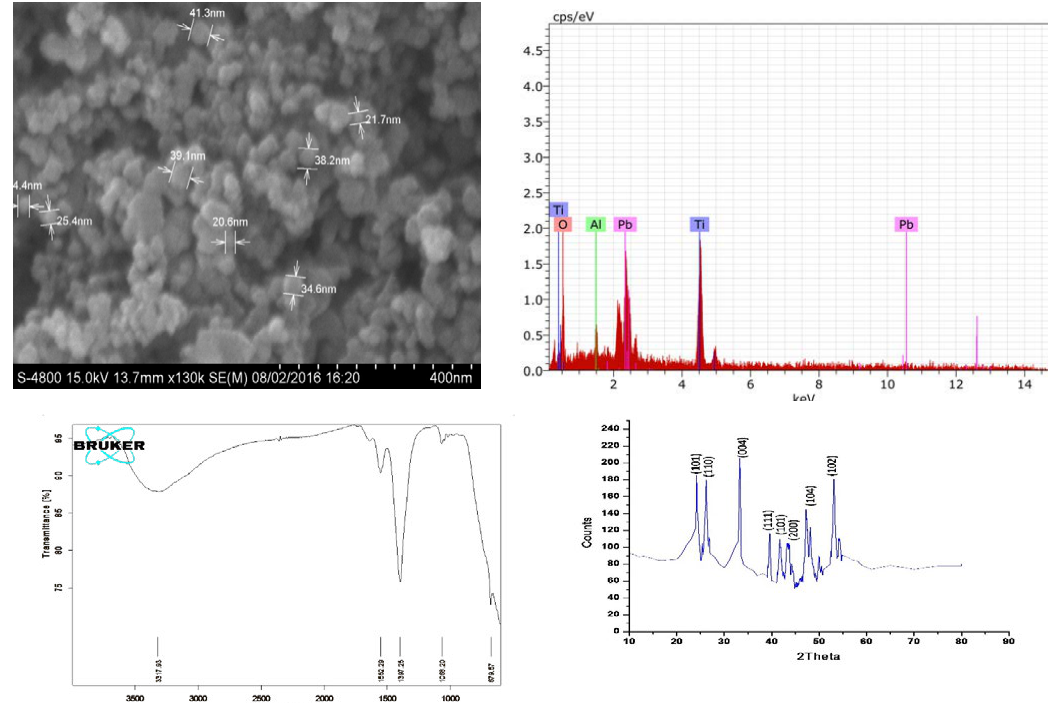
Fig. 1: (a) SEM Image and (b) EDX spectra of ATPO-NPs c) FT-IR and d) XRD Spectra of ATPO-NPs